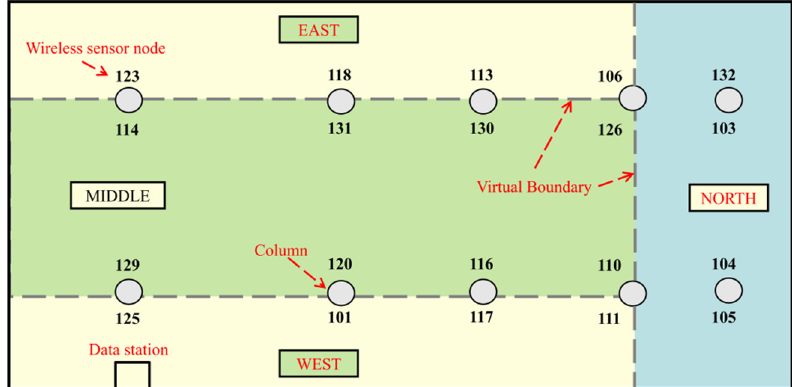
Figure 1. Layout of WSN test-bed.